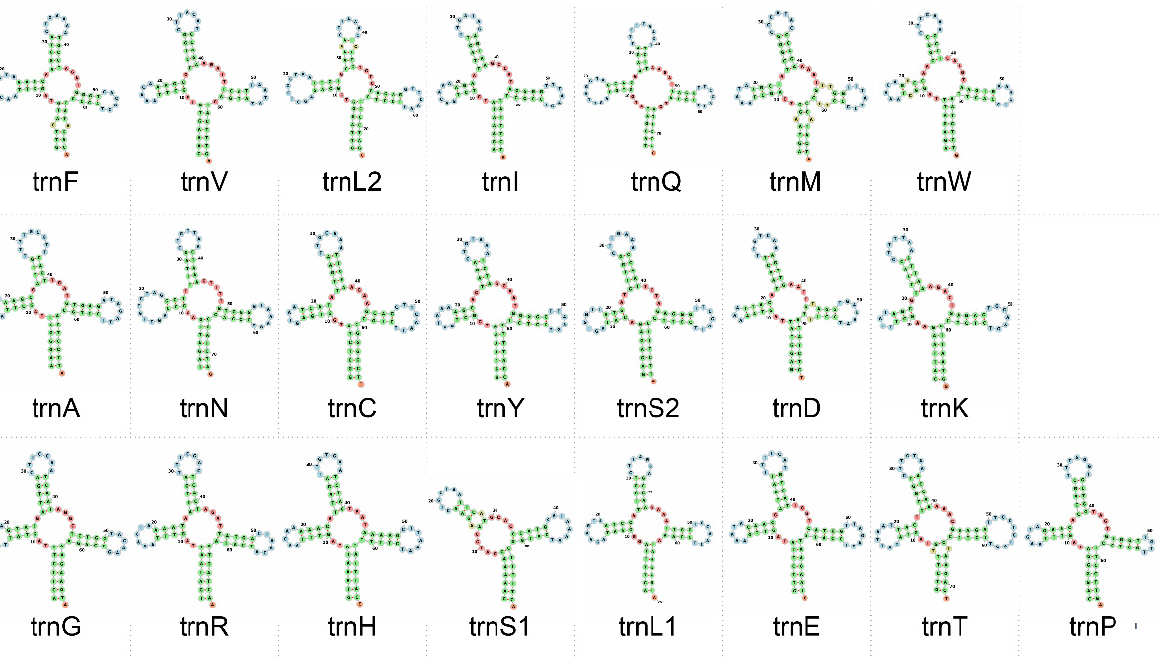
Figure 4. Secondary structure of tRNAs in the mitochondrial genome of the panda bear ( Ailuropoda melanoleuca) . Out of 22 tRNA genes, 21 exhibit a ‘cloverleaf’ secondary structure. tRNA-Ser1 invariably lacked the entire dihydroxyuridine (DHU) arm (stem + loop). Secondary structures visualized in the Forna web server. The secondary structure of tRNA genes was similar in U. thibetanus and E. glacialis to that found in A. melanoleuca .